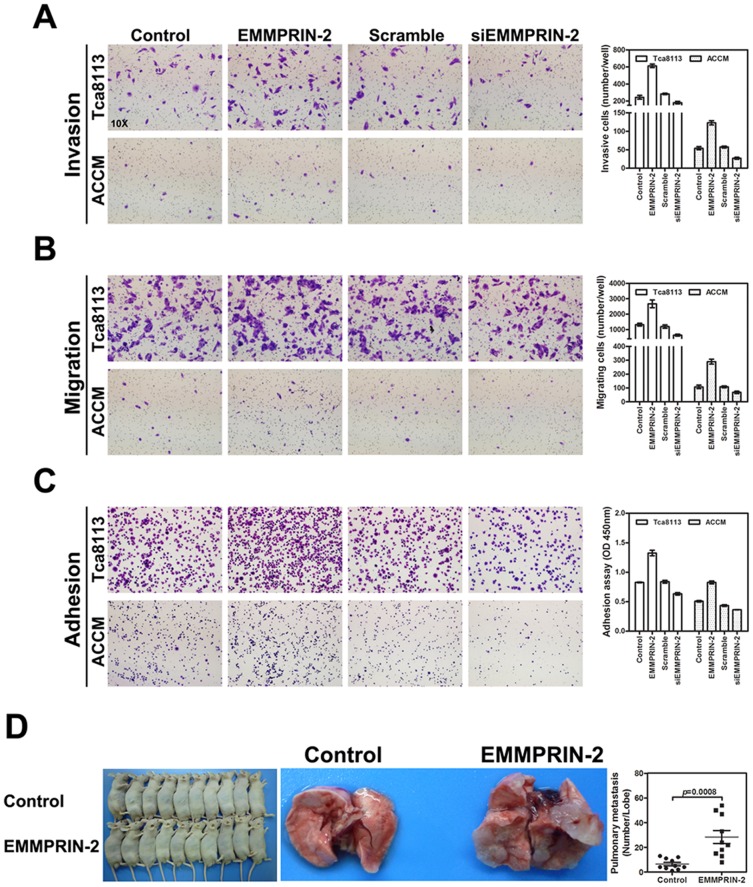
EMMPRIN-2 expression modulated head and neck cancer cell invasion, migration, and adhesion in vitro, and metastasis in vivo.Exogenous overexpression of EMMPRIN-2 using an expression construct enhanced head and neck cancer cell invasion (A), migration (B) and adhesion (C), whereas down-regulation of EMMPRIN-2 using siRNA (siEMMPRIN-2) suppressed head and neck cancer cell invasion (A), migration (B) and adhesion (C). The differences in cell invasion, migration and adhesion between the construct- or siRNA-transfected groups and the mock controls were statistically significant (p<0.05). The effects of EMMPRIN-2 expression on tumor metastasis in vivo were further investigated in nude mouse models. (D) Tca8113 head and neck cancer cell lines with stably expressed EMMPRIN-2 or a mock control vector were intravenously injected into nude mice. Metastatic foci in the lungs of nude mice were calculated at week 6 after injection. The average number of metastatic foci in the lungs from the mice with the EMMPRIN-2 expressing cells was 28.4 compared to 6.4 in the lungs from the mice injected with cells bearing the control vector (p<0.01).